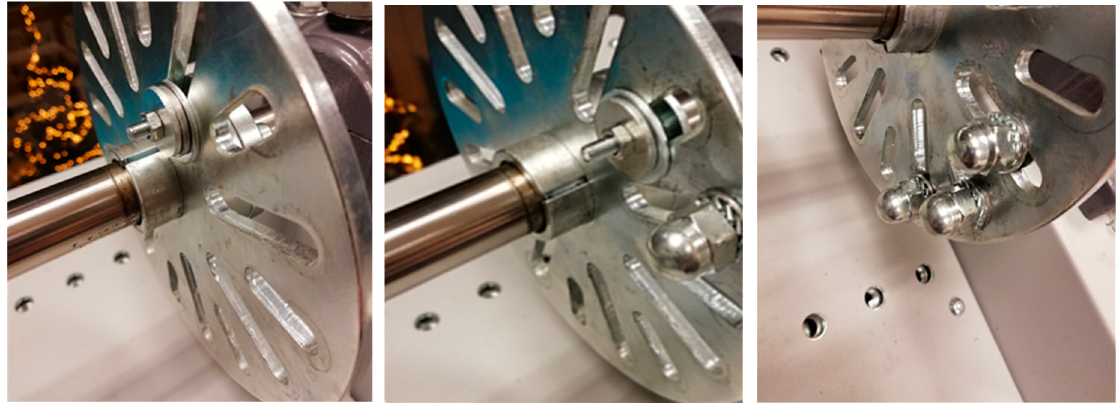
Figure 8. From the left: initial and two subsequent intermediate imbalance